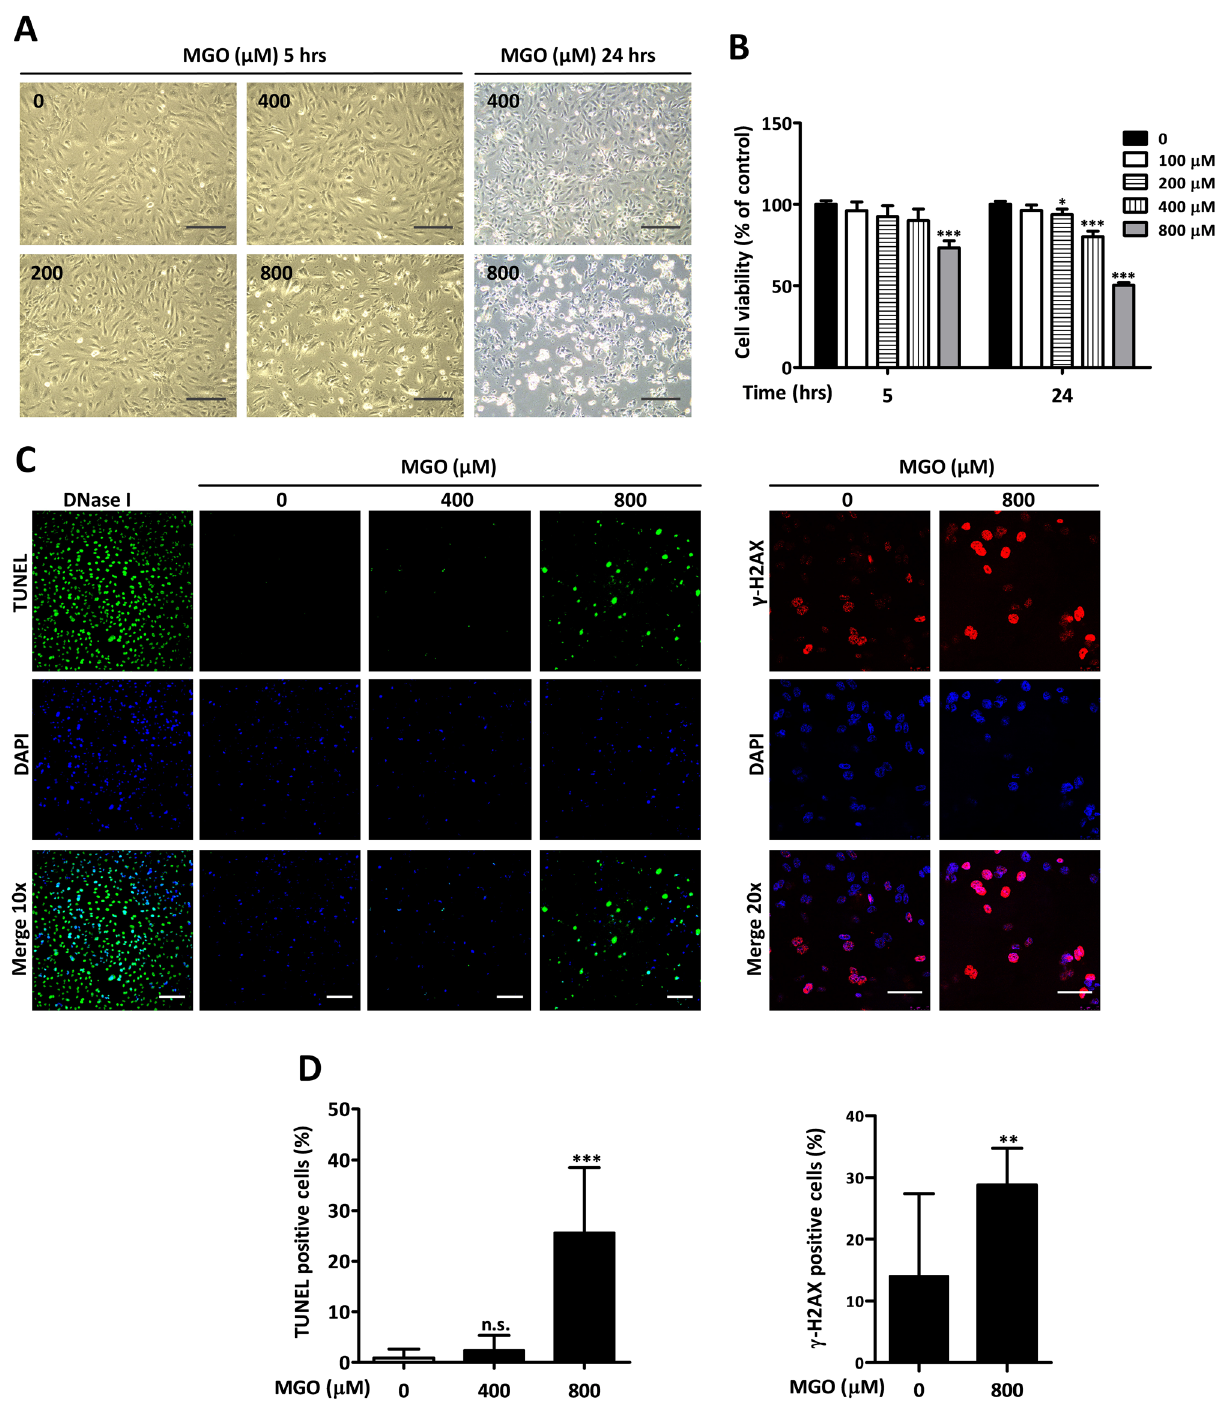
Figure 1. Cell morphology and viability are affected by MGO. ( A ) HUVECs were stimulated with different concentrations of MGO. The cells were inspected by phase-contrast microscopy after 5 and 24 h. Changes in cell morphology, i.e. cell detachment, deformation and shrinkage, were already observed after 5 h at the highest MGO concentration. Original magnification: 10x, scale bar represents 250 µm. ( B ) Cell viability was assessed by MTT assay after 5 h (panel to the left) and 24 h (panel to the right) post MGO treatment. The results are expressed as mean % of viable cells ± SD of 5 independent experiments. * p < 0.05 and *** p < 0.001 vs. no MGO. ( C ) DNA double stand breaks (panel to the left) and expression of γ-H2AX (panel to the right) were assessed by TUNEL and immunofluorescence respectively. DAPI was used to stain the nucleus. DNase I served as a positive control. Cells were visualized under fluorescence microscope. Original magnification: 10 × for TUNEL, scale bar represents 150 µm; 20 × for γ-H2AX, scale bar represents 50 µm. At least 3 independent experiments were performed. ( D ) The quantification of positive TUNEL and γ-H2AX cells are shown as mean % of positive cells ± SD. ** p < 0.01 and *** p < 0.001 vs. no MGO, n.s. represents